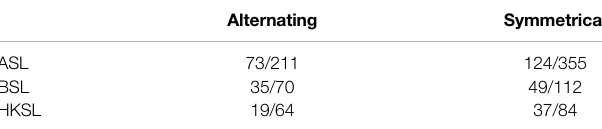
TABLE 3 | Number of iconic tokens for alternating and symmetrical signs in the three sign languages.